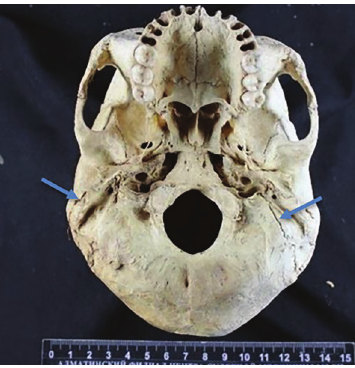
Figure 6 - View of the base of the skull from below (the arrow indicates the abnormal seams of the occipital bone)